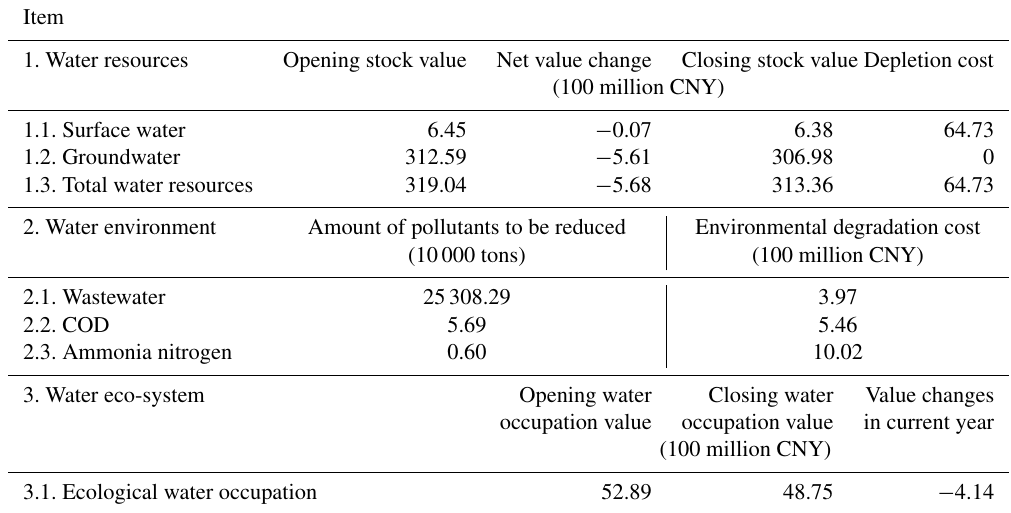
Table 3. The value accounts of water resources assets in Chengdu.